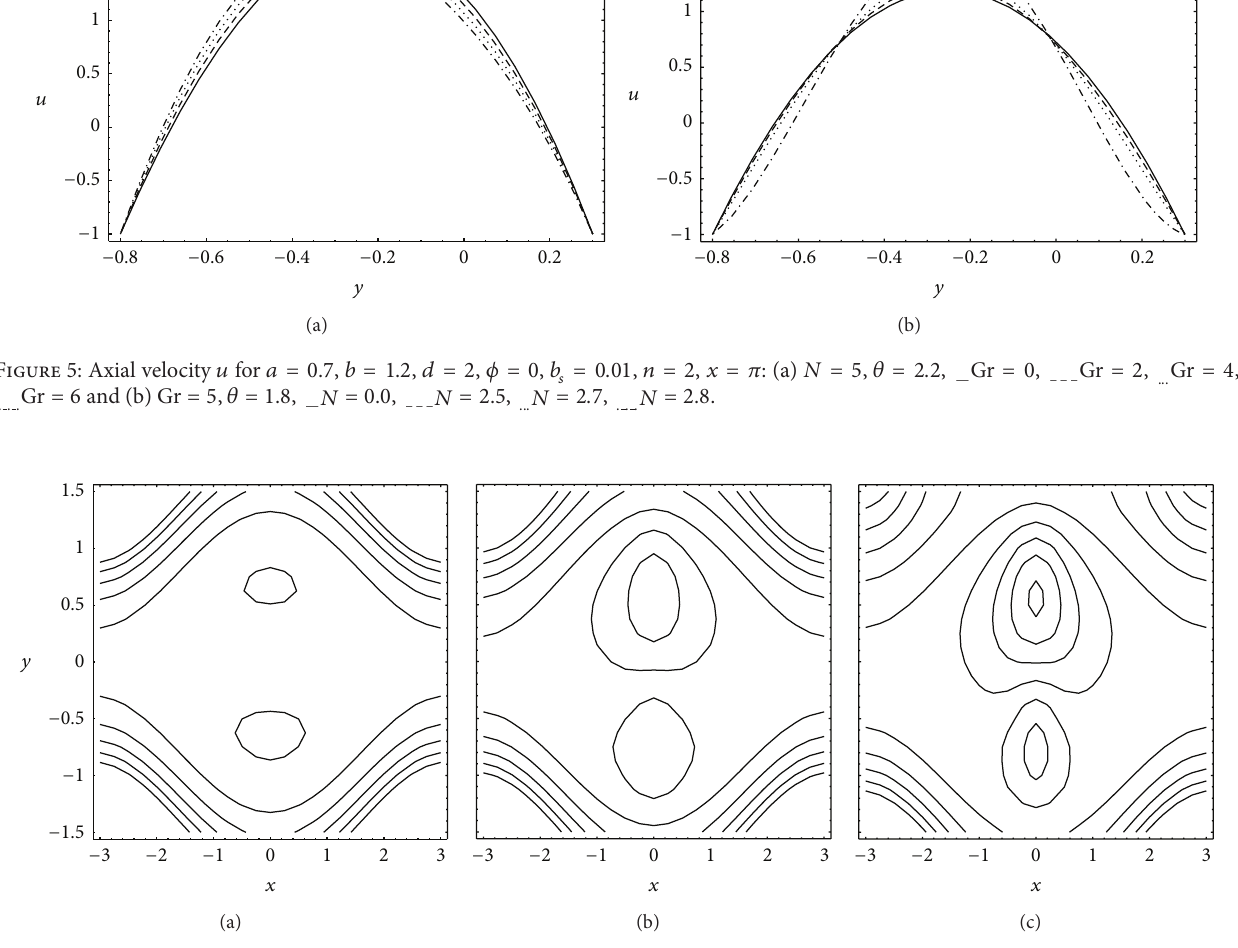
Figure 6: Streamlines for different Gr (a) 0, (b) 3 and (c) 9 with fixed 𝑎 = 0.5 , 𝑏 = 0.5 , 𝑑 = 1 , 𝜙 = 0 , 𝑁 = 1 , 𝜃 = 1 , 𝑛 = 2 , and 𝑏 𝑠 = 0.01 .